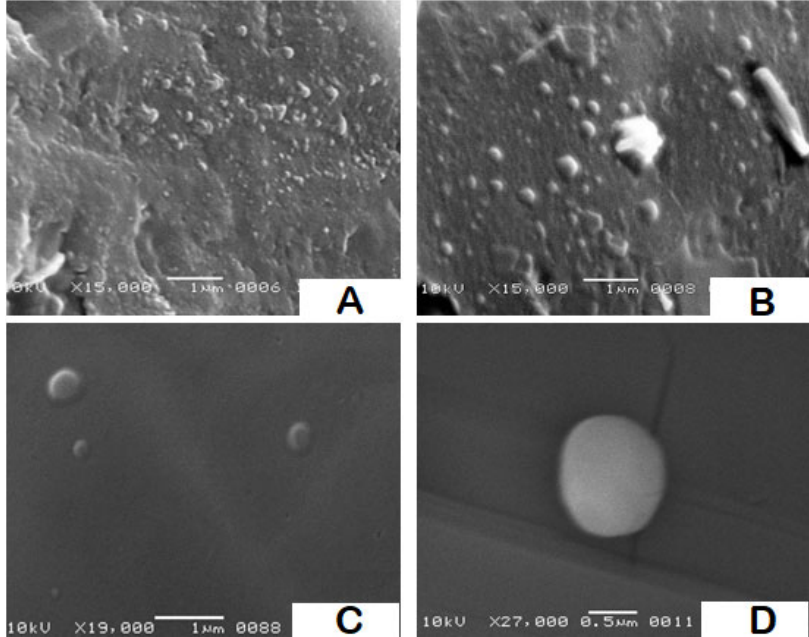
Figure 4. SEM photomicrographs for SLN formulations F2, F9, and F14: ( A ) a field containing a range of particles from F2 using 15,000× magnification power, ( B ) a field containing a range of particles from F9 using 15,000× magnification power, and ( C , D ) two high resolution fields containing few particles from F14 using magnification power 19,000× and 27,000×, respectively.